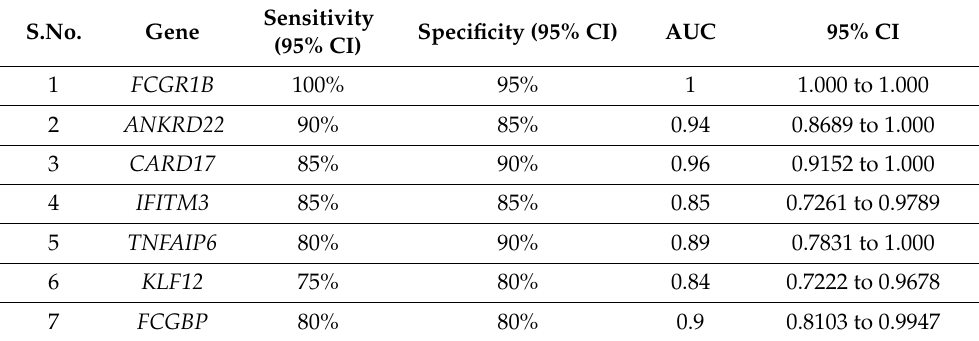
Table 5. Sensitivity, specificity, and AUC of seven-gene signature in discriminating active and latent